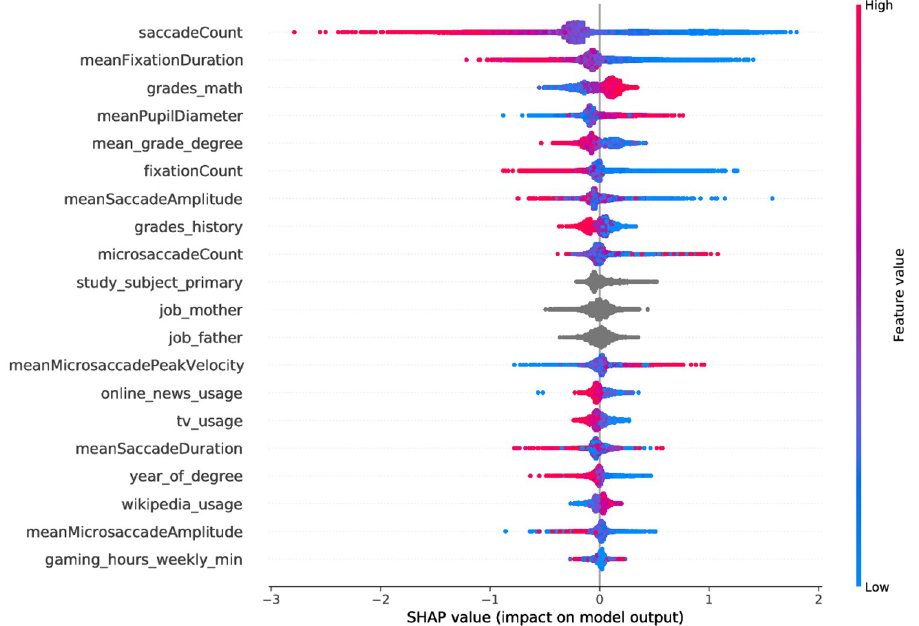
Fig 6. Summary plot of the approx. Shapeley values, that is, the density of the marginal contributions of the features in the GBDT model that uses only eye related and socio-demographic features. Red denotes high feature values, whereas blue indicates low feature values, and grey show categorical values or missing values that cannot be assigned a feature value.